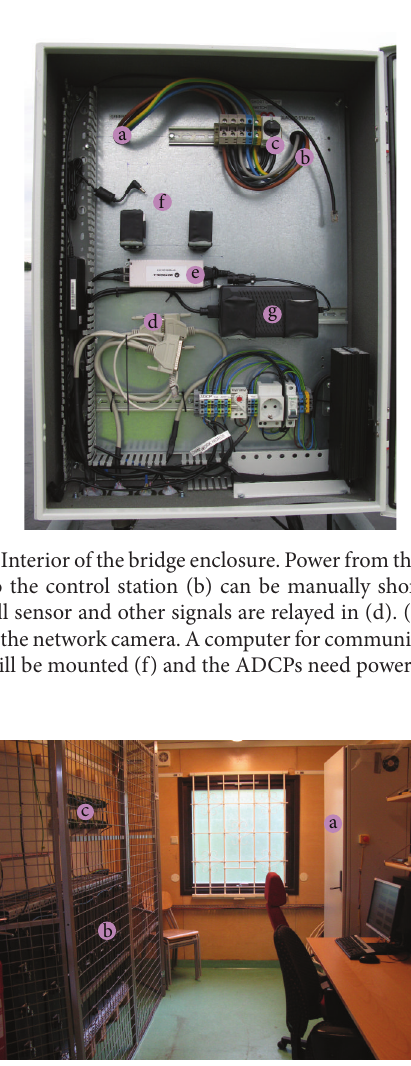
Figure 8: The main enclosure (a), the regular load (b), and the emergency stop load (c) in the control